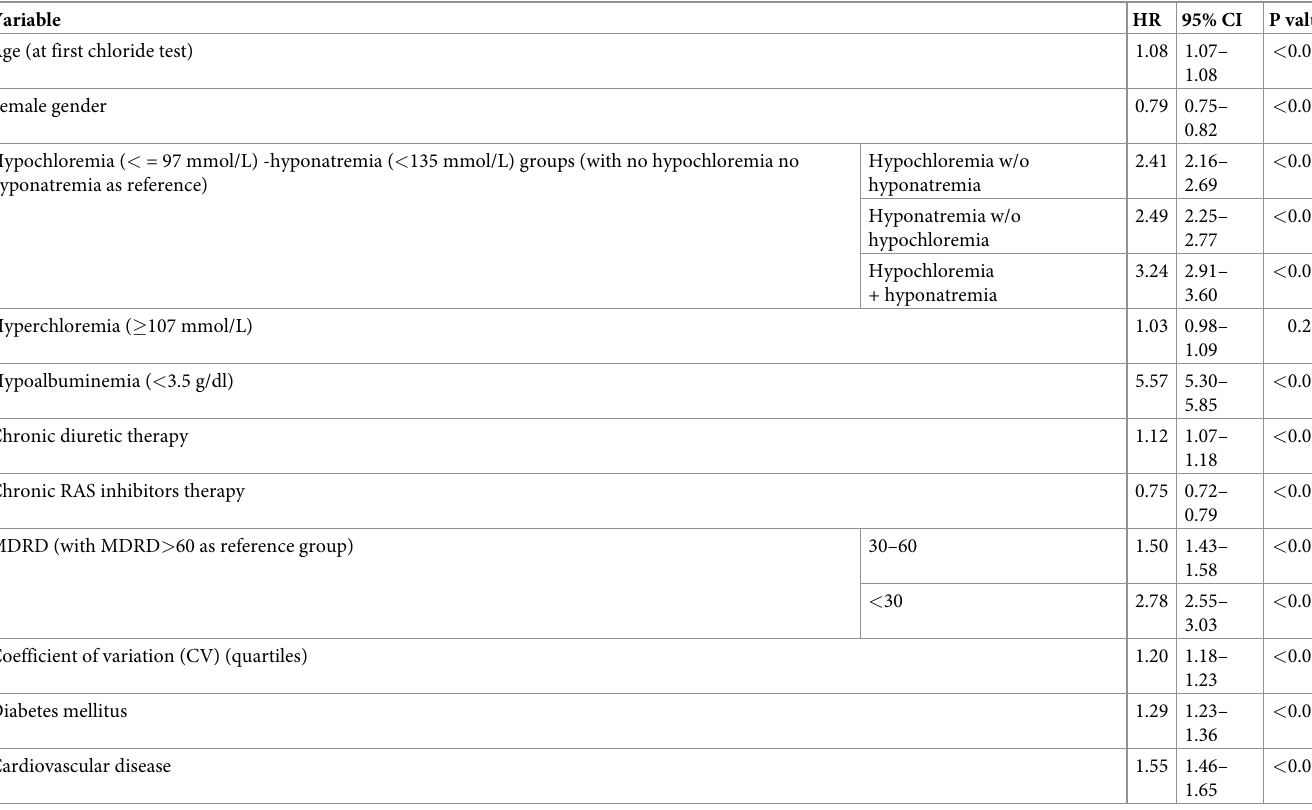
Table 3. Multivariate analysis (Cox regression with same patients clustering) for all-cause mortality (n = 556,595 tests of 105,207 patients).